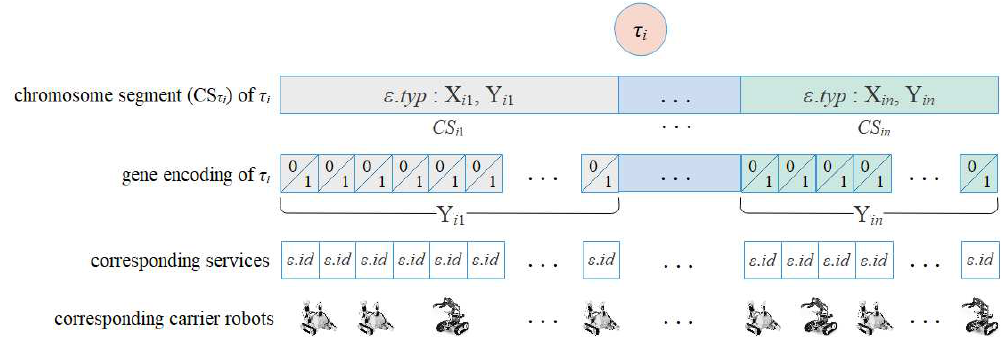
Figure 2. Chromosome Piece and its Coding for τ i